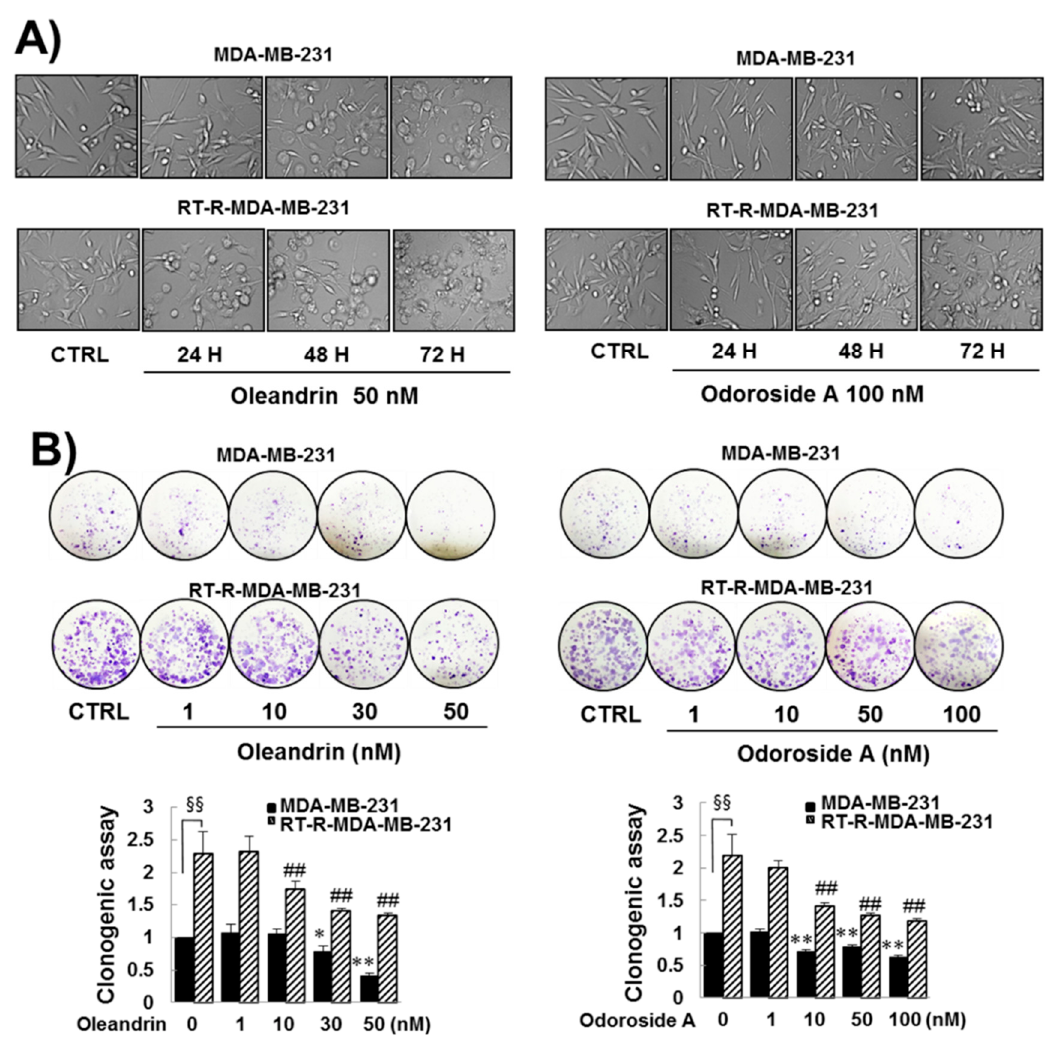
Figure 2. Effects of oleandrin and odoroside A on cell morphology ( A ) and colony formation ( B ) in MDA-MB-231 and RT-R-MDA-MB-231 cells. ( A ) Cells were treated with oleandrin (50 nM) and odoroside A (100 nM) for 24–72 h. Then, the morphologic changes of the cells were observed under a microscope (200 × ). ( B ) MDA-MB-231 and RT-MDA-MB-231 cells seeded in six-well plates (1000 cells/well) were treated with oleandrin and odoroside A at the indicated doses. After 24 h, the culture medium was discarded and replaced with fresh medium every 2–3 days. After 1–2 weeks, the cells were fixed, stained using crystal violet and counted. The values are expressed as the means ± SEM from three independent determinations. * p < 0.05, ** p < 0.01 compared with the control group of MDA-MB-231 cells; ## p < 0.01 compared with control of RT-R-MDA-MB-231 cells. §§ p < 0.01 between MDA-MB-231 and RT-R-MDA-MB-231 cells.